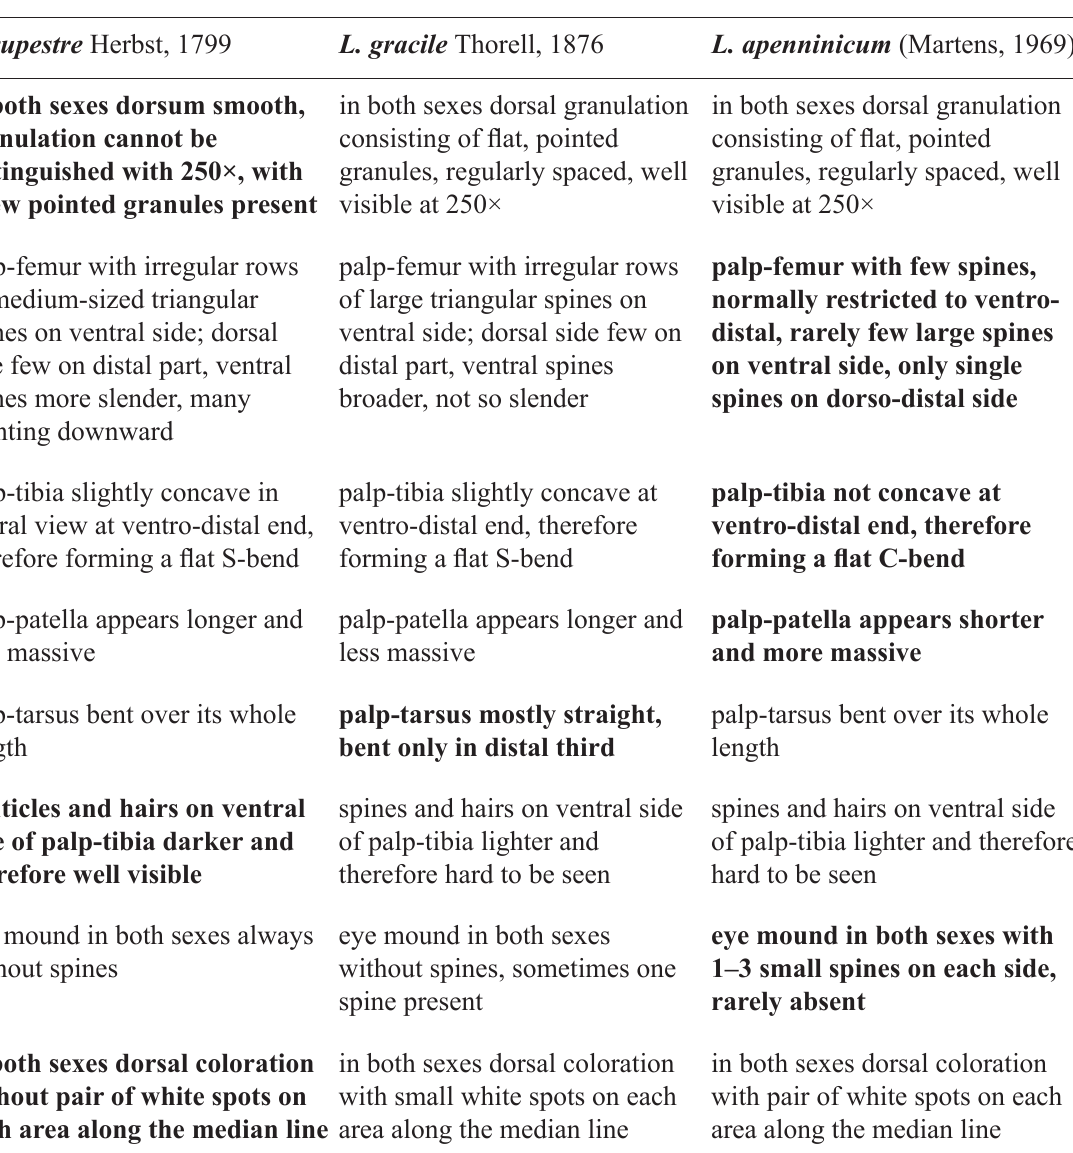
Table 1. Comparison of somatic characters of Leiobunum apenninicum (Martens, 1969), L. gracile Thorell, 1876 and L. rupestre Herbst, 1799. L. subalpinum Komposch, 1998 is not included, because it is very similar to L. rupestre and is easily identified by its black coxal markings. For comparison with L. rupestre we refer to Komposch (1998). If not otherwise mentioned, characters apply to males only. Characters outlining a single species are given in bold, more variable characters are given in italics. The combination of several characters for determination is advised. Palpal spination is variable, apparently the appearance in ordered rows is an individual character. Body coloration varies with age and population, aged specimens are